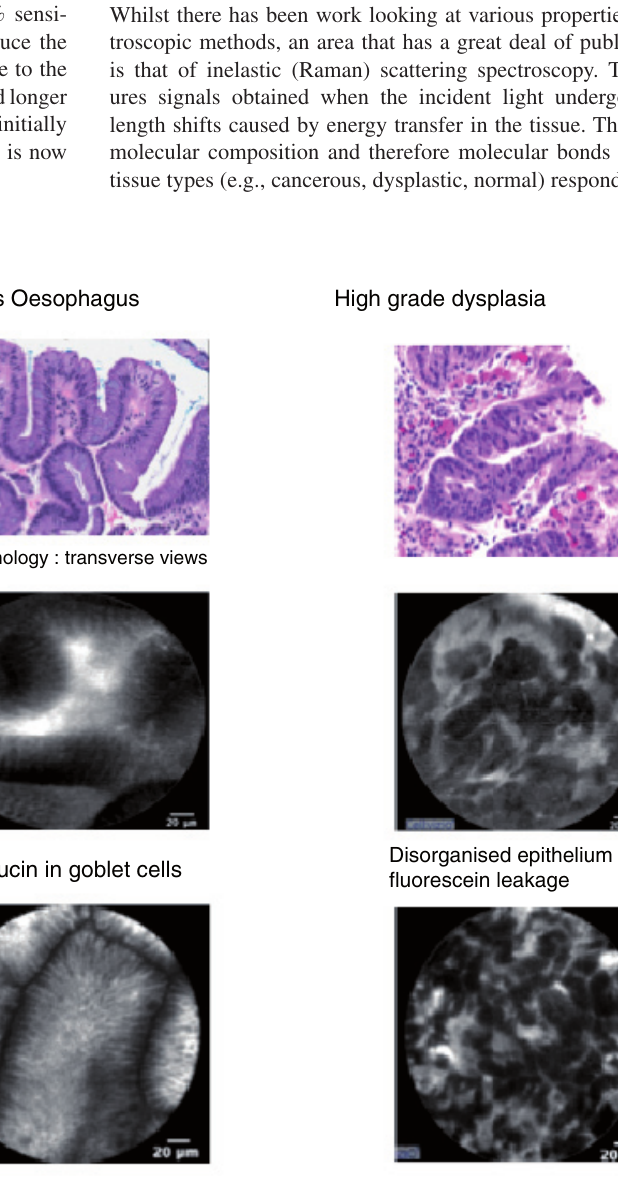
Figure 3. Confocal endomicroscopy (CLE) images demonstrating the ability to visualize individual cells and thus make an in vivo histological diagnosis. These images are taken from Barrett’s esophagus.